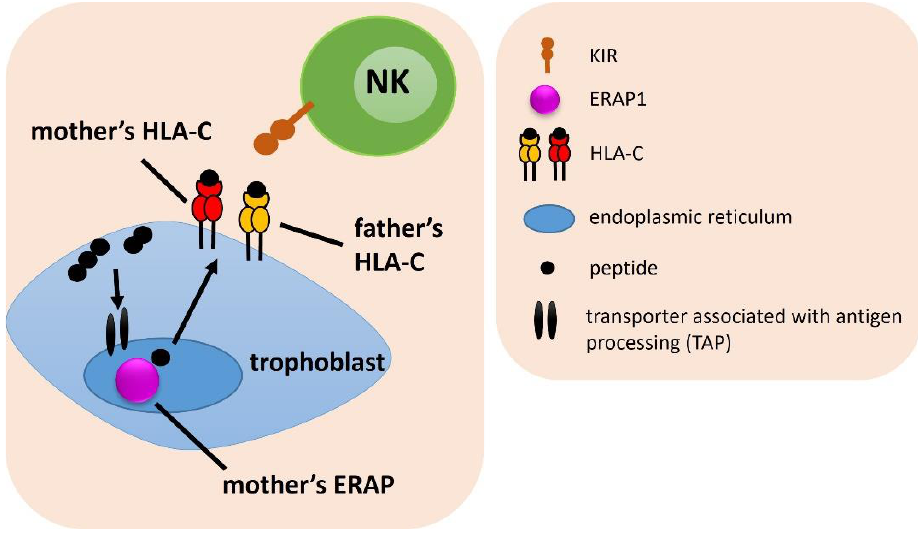
Figure 6 . The influence of a mother’s ERAP/HLA-C and a father’s HLA-C on embryo implantation. The arrows indicate the successive stages of the formation of antigenic peptides.